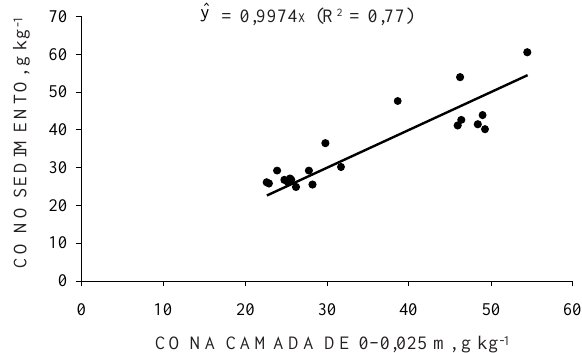
Fgura 2. Regressão linear simples da concentração de carbono orgânico (CO) na camada de 0– 0,025 m do solo com a respectiva concentração nos sedimentos transportados pela erosão hídrica, em diferentes sistemas de manejo de um Nitossolo Háplico alumínico (quatro determinações no cultivo do milho e 15 no